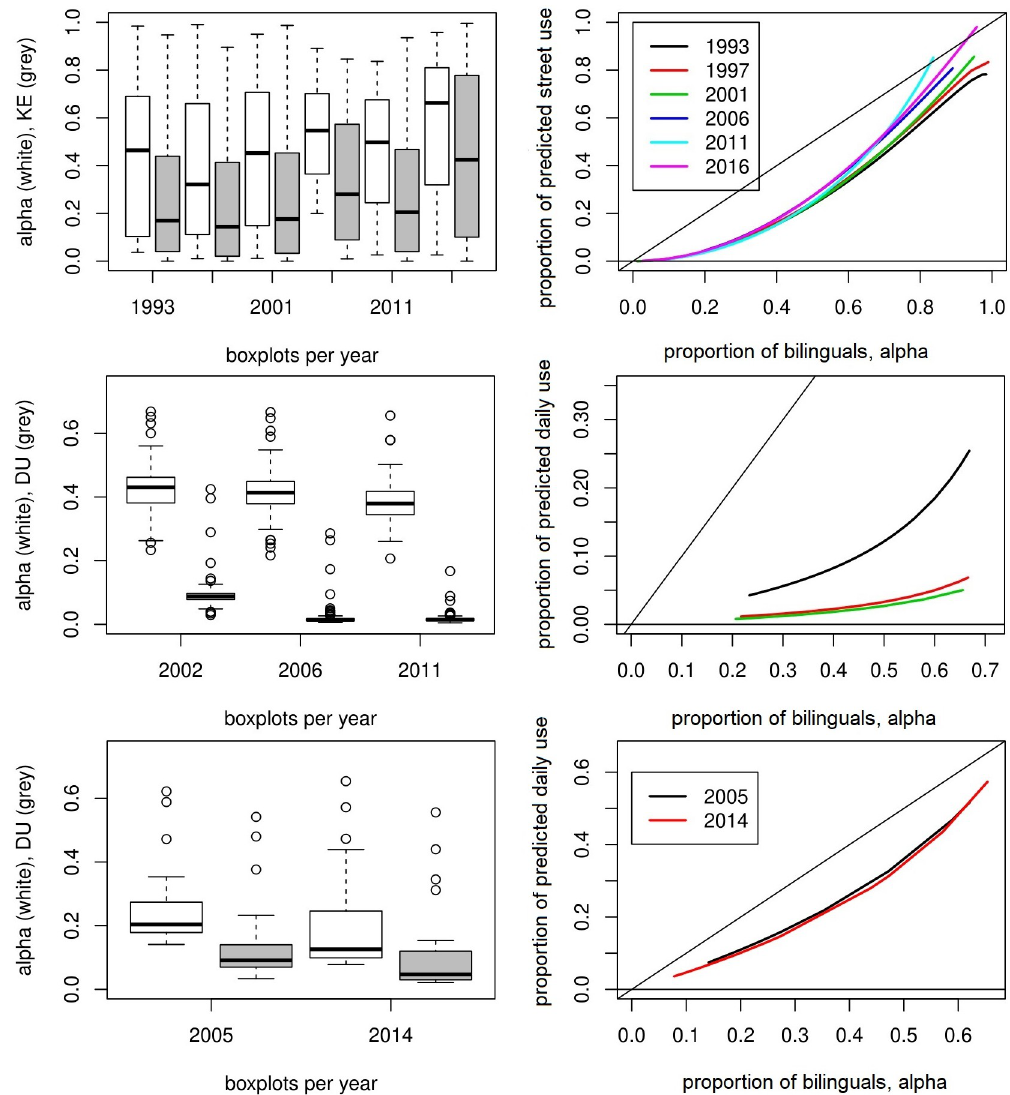
Fig 2. Development of α and use of Basque (upper panel), Irish (centre) and Welsh (lower panel) over time. For each year, PKE ( α i ) associates to each local α i the predicted local street use of Basque in equilibrium; and so does the PDU ( α i ) for Irish and Welsh. On the left we see box-plots showing the development of α (white) and KE , respectively DU distributions (grey) over